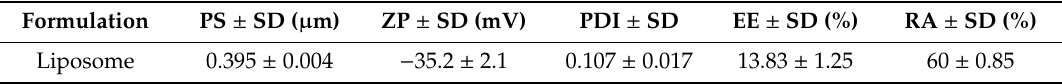
Table 6. Characterization of liposomes ( n =